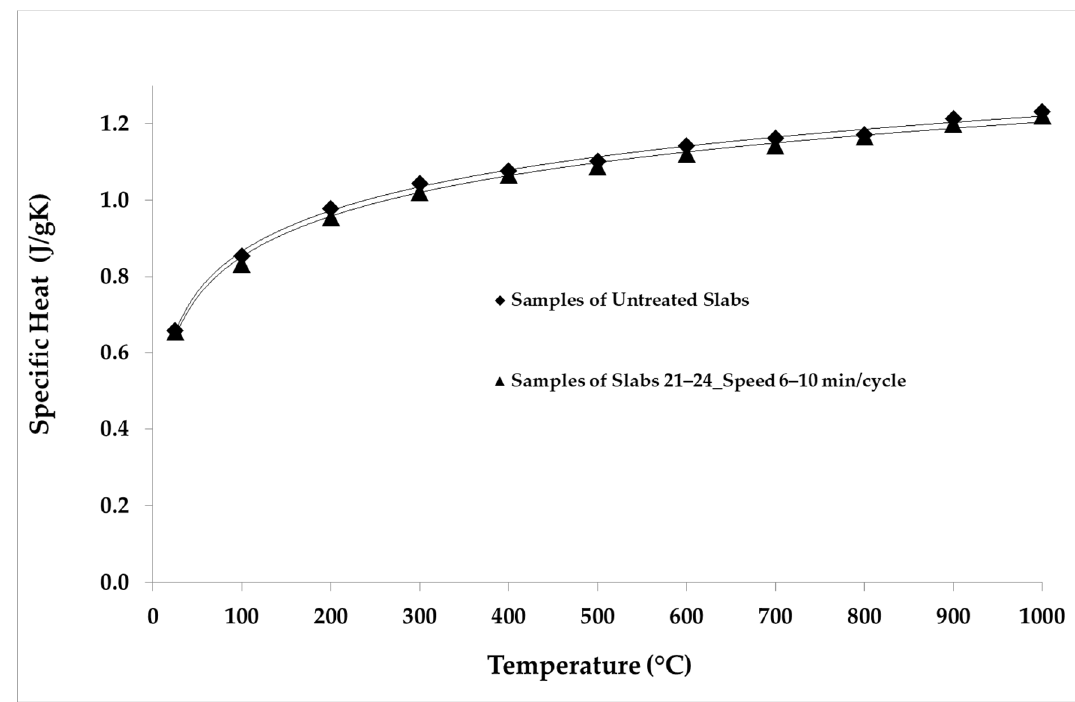
Figure 12. Specific heat values of untreated samples and samples aged in the temperature range 300–1000 ◦ C.